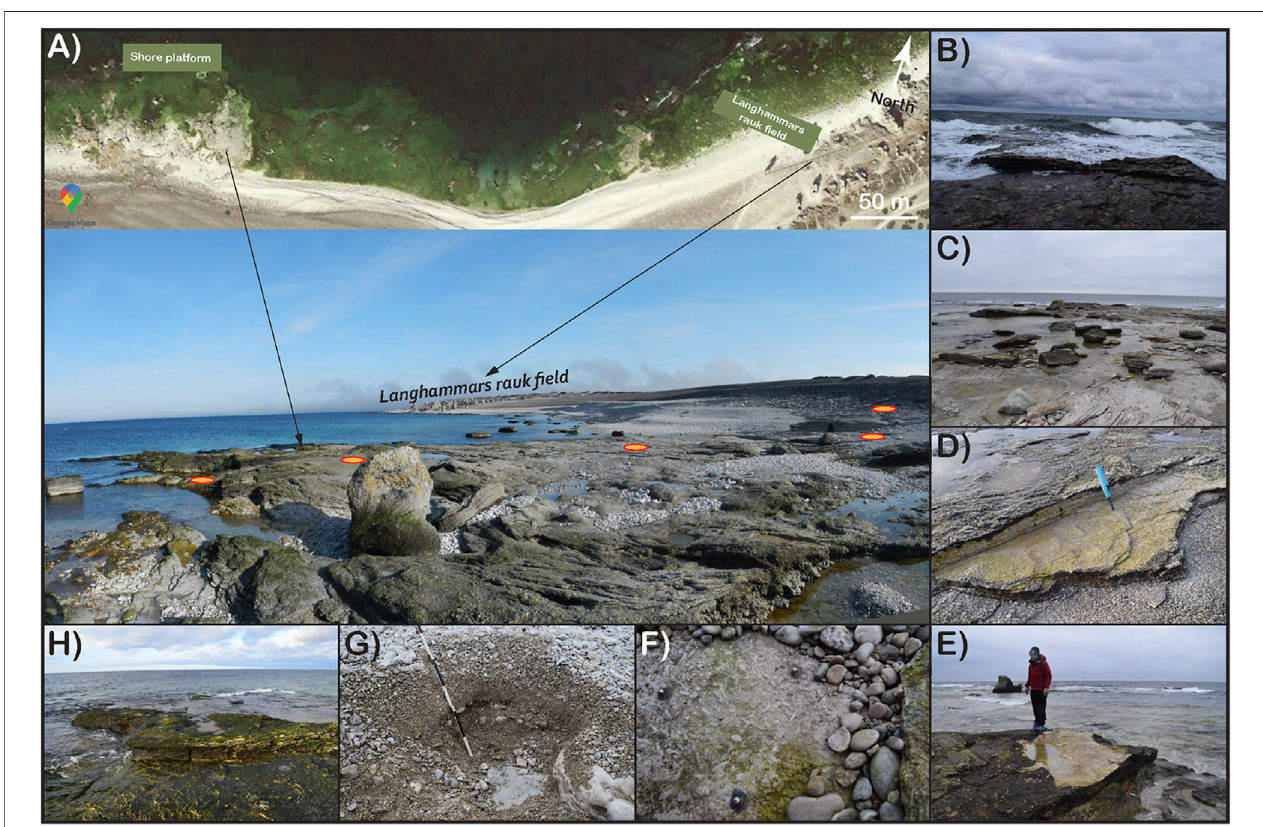
FIGURE 5 | Exposed shore platform nearby Langhammars rauk fi eld, where an attempt to monitor platform downwearing rates was carried out in years 2019 – 2021. (A) Almost horizontal shore platform with a small inward slope following the dip of limestone strata. Orange dots mark the location of TMEM stations. (B) Shoreplatformduringthestormyconditionswhentheentiresurfaceisinundatedbyapproachingwaves; (C) remnantsofrauksandrockblockserodeddirectlyfromthe platform spread across the platform; (D) erosion scar formed between 2016 – 2019, eroded block/slab was not located in the surroundings, suggesting further disintegration and transport to deeper waters by waves; (E) freshly exposed rock surface through spalling of platform; (F) smoothed and polished by pebble movement platform in an abrasion strip close to the high tide; (G) smoothed/abraded section of platform covered by ca.0.4 – 0.5 m thick gravel-dominated beach sediments after storm season. The same platform was sediment-free season before. (H) Rugged surface with full biological coverage near low tide.